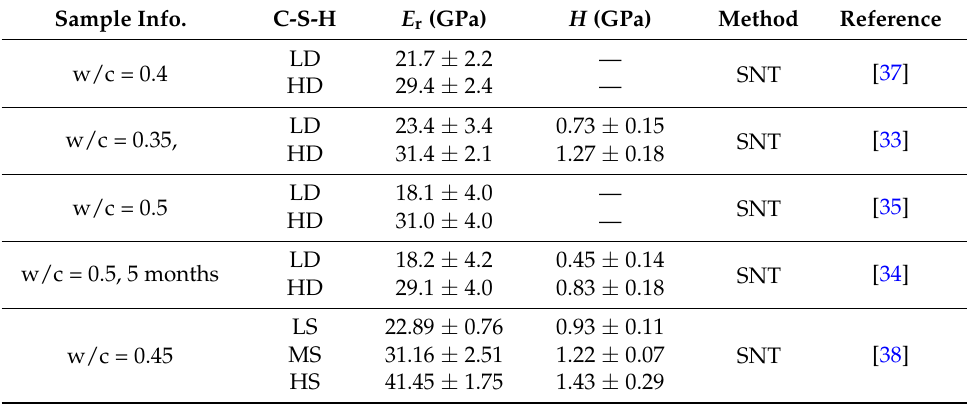
Table 4. Summary of nanoindentation properties of